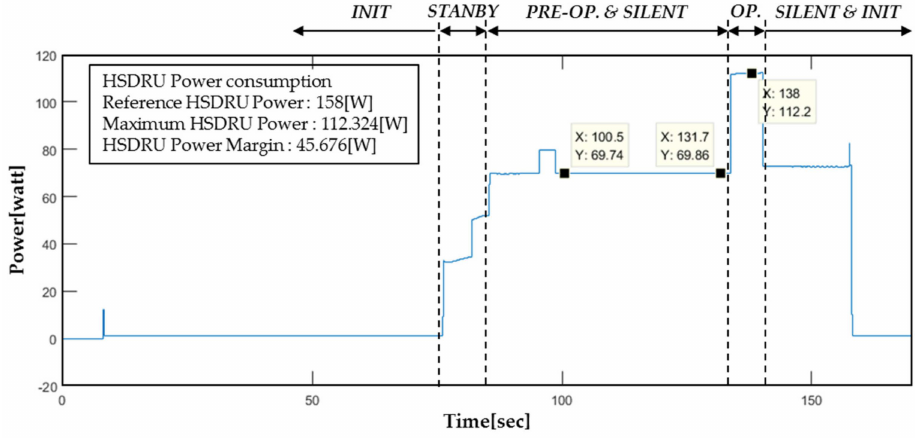
Figure 19. x -axis power consumption test results after x -axis random vibration